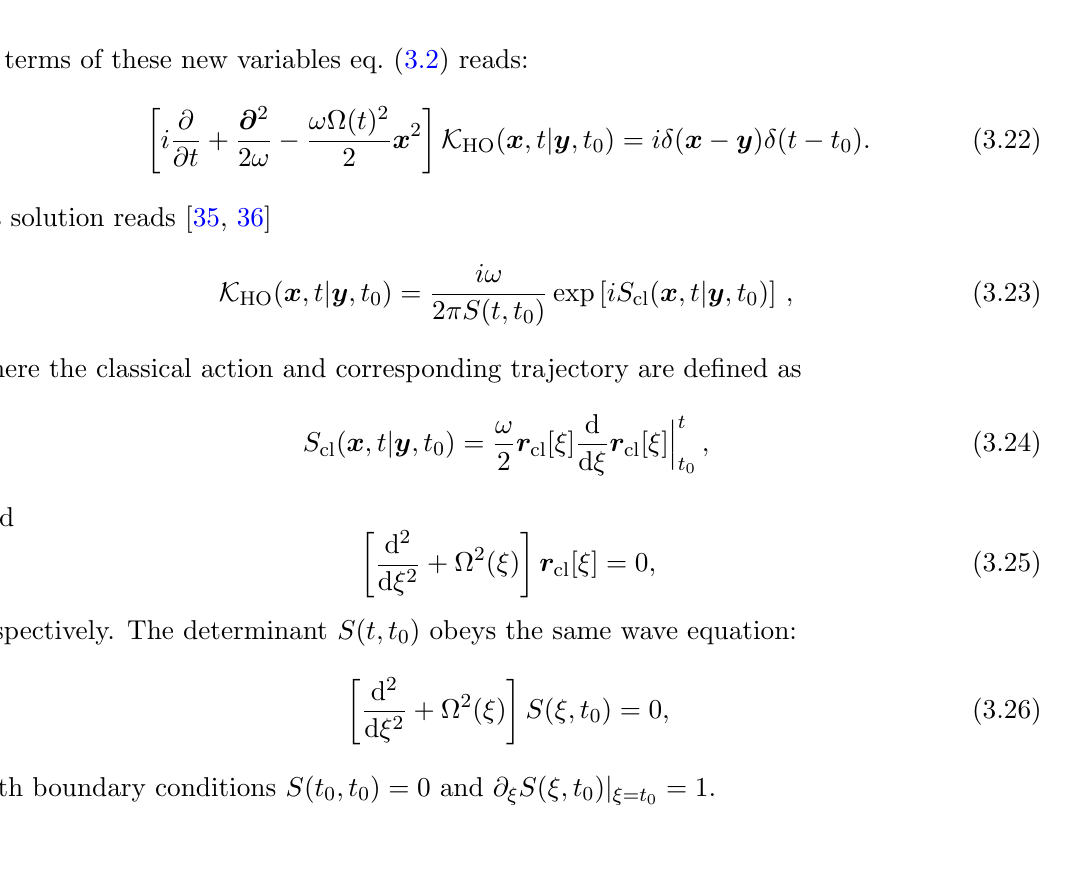
Figure 2 . The medium-induced spectrum to leading order in opacity (GLV) (dashed) and in multiple soft scattering approximation (BDMPS) (solid blue) computed for the following set of parameters: ^ q 0 = 0 : 1 GeV 3 , L = 4 fm, (cid:22) = 0 : 3 GeV and we have set the overall pre-factor (cid:22) (cid:11) = 1. This corresponds to ^ q ^ q 0 ln(^ q 0 L=(cid:22) 2 ) = 1 : 5 GeV 2 /fm, ! BH 0 : 08 GeV and ! c ^ q 0 L 2 = 40 (cid:24) ’ (cid:17)